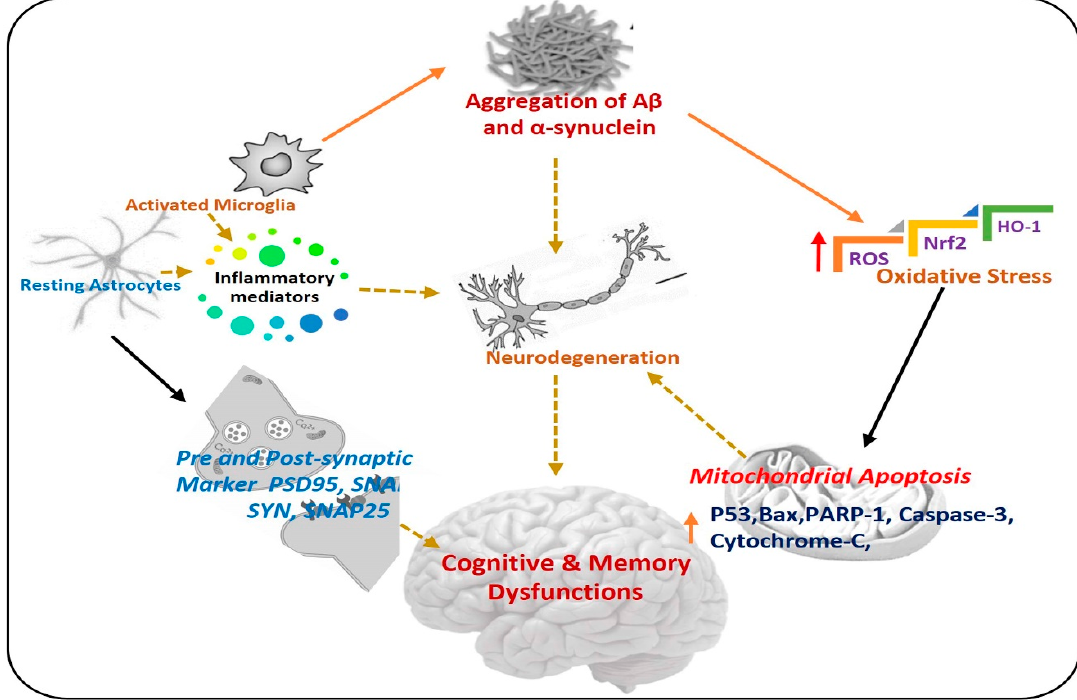
Figure 1. Pathogenesis of neurodegenerative diseases. A diagram showing the role of activated astrocytes, microglia, neuroinflammation, and elevated oxidative stress in the procession of neurodegeneration. A β : Amyloid beta, ROS: Reactive oxygen species, Nrf2: Nuclear factor-2 related factor-2, HO-1: Heme-oxygenase-1, PSD-95: postsynaptic density protein 95, SNAP25: Synaptosome Associated Protein 25, Syn: Syntaxin.